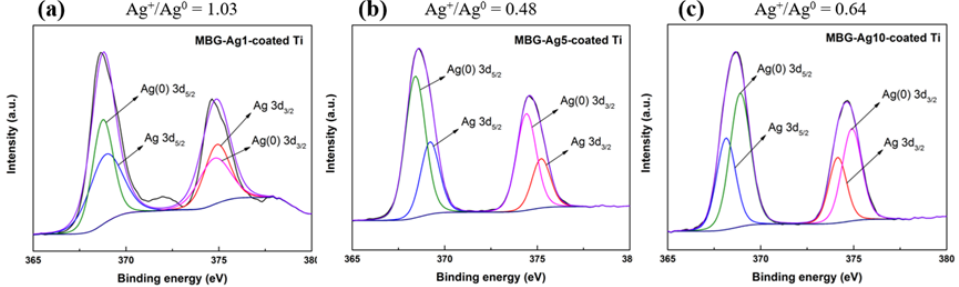
Figure 8. XPS patterns of ( a ) MBG–Ag1–coated Ti, ( b ) MBG–Ag5–coated Ti, and ( c ) MBG–Ag10–coated Ti. Table 1. XPS data of MBG–Ag–coated Ti.